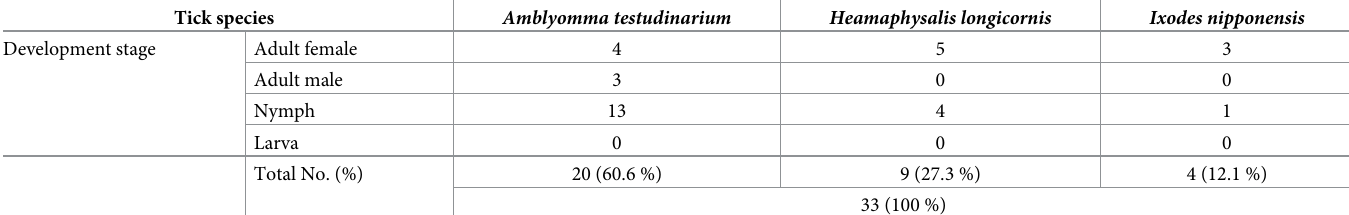
Table 2. Developmental stages and species of ticks removed from tick-bitten humans determined from both morphological identification and 16S rDNA-targeting conventional PCR. Tick